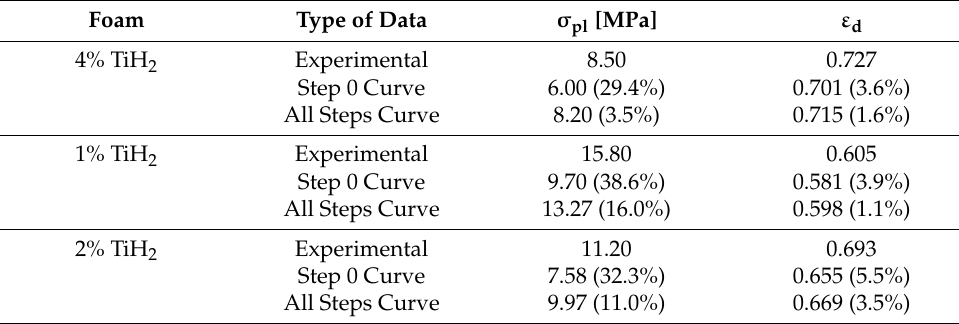
Table 6. Theoretical and experimental parameters of compression curves.